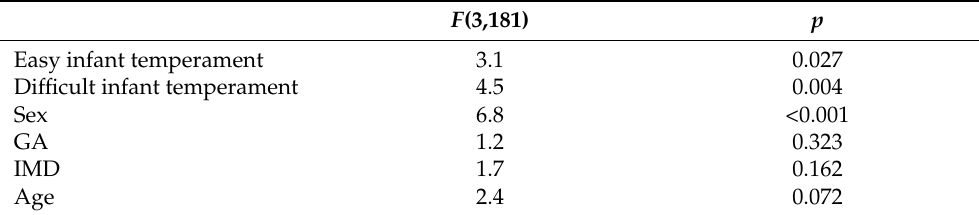
Table 2. Results of the multivariate regression analysis jointly regressing childhood temperament (Negative Affect, Surgency and Effortful Control) on infant temperament (easy and difficult), con- trolling for age, sex, gestational age (GA) and index of multiple deprivation (IMD). An uncorrected significance threshold of p = 0.05 was used.